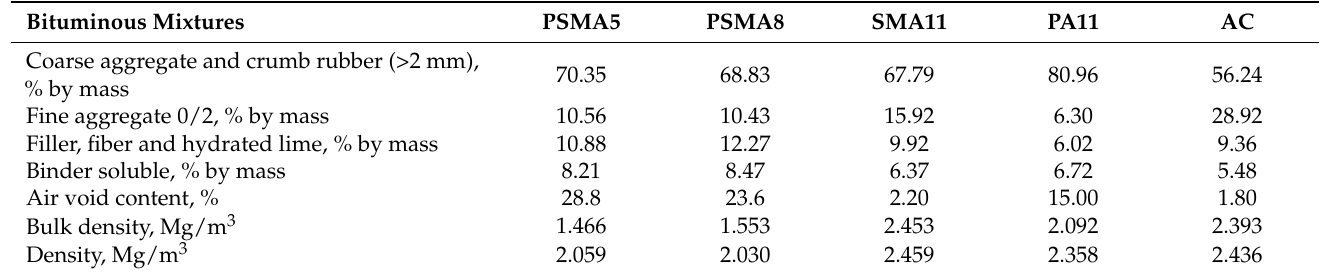
Table 1. Characteristics of the bituminous mixtures according to research at the Bialystok University of